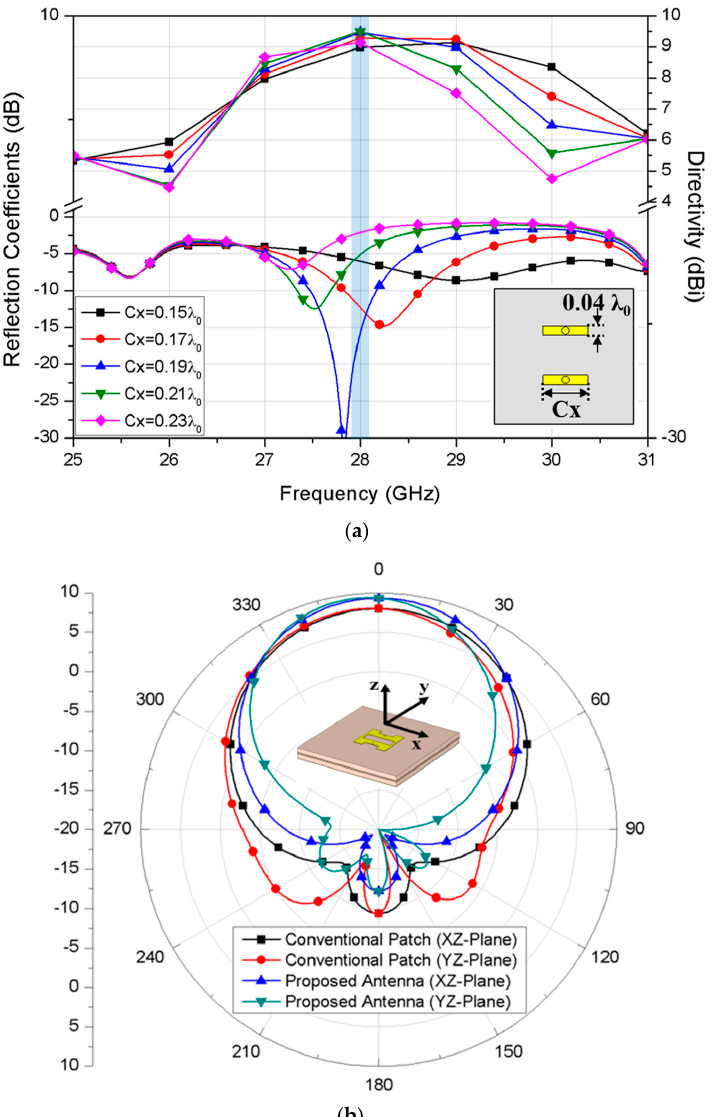
Figure 3. Proposed antenna structure with impedance variation according to Cx value. Further, the effect of variation in Cx value on the achievable directivity is also simulated as shown in Figure 4a. Having the Cx and Cy set to 0.19 λ 0 and 0.04 λ 0 , respectively, it confirms that simultaneous matching for reflection coefficient and maximum directivity were achieved at the target frequency of 28 GHz. Then, radiation pattern of the proposed antenna is simulated and compared with the conventional patch antenna with the same ground size as shown in Figure 4b.